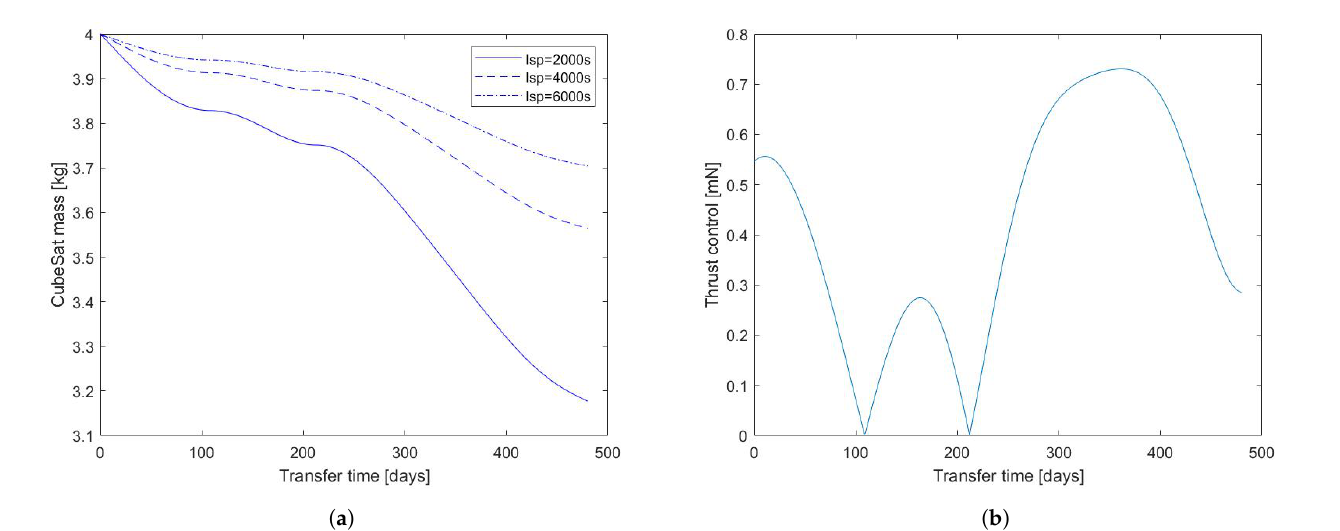
Figure 5. Target asteroid: 65679 ( a ) mass profiles in function of the Isp, ( b ) Required thrust